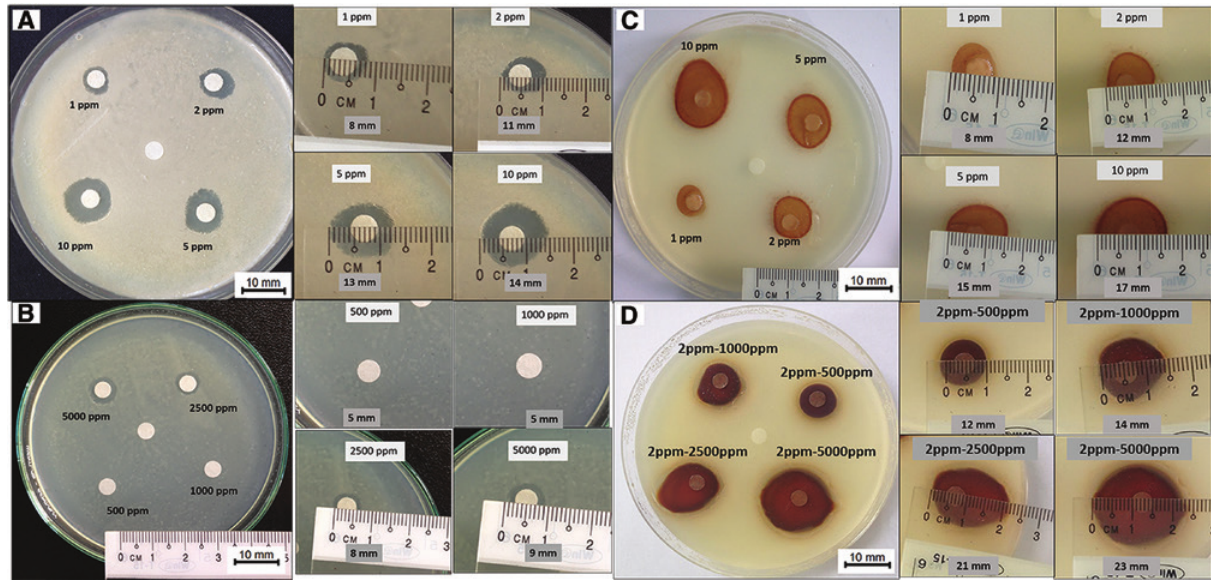
Figure 5: Average inhibition zones observed of AgNPs (A), Zi (B), Ag@CS (C), and Ag@CS-Zi (D) against Neoscytalidium dimidiatum